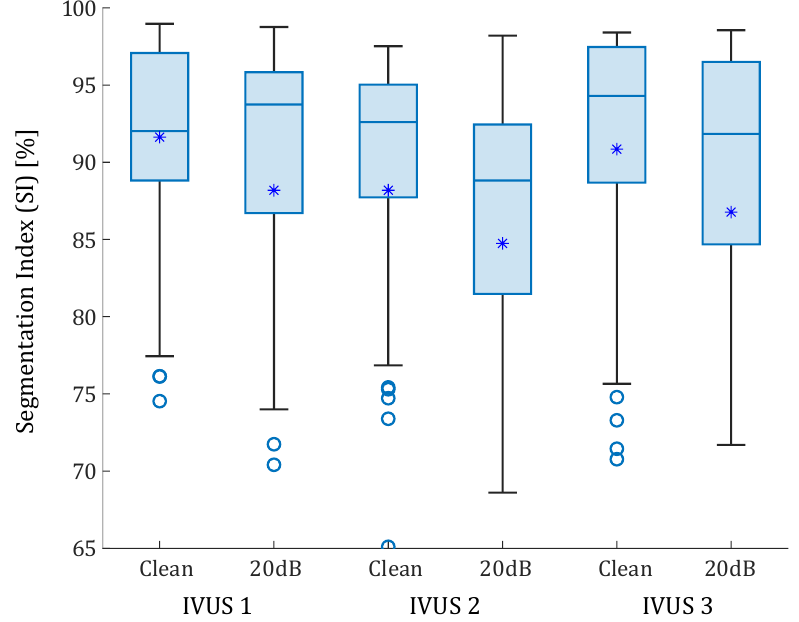
Figure 8. Box-plots of the SI values of the real IVUS geometries. The three plaques were analyzed with clean strains and with 20 dB of SNR. The median values are represented with a horizontal line. The median values were 92.02% and 93.74% for the first IVUS geometry, with and without noise; 92.60% and 88.82% for the second IVUS geometry; and 94.30% 91.84% for third IVUS geometry, respectively. Mean values are represented with asterisks. Outliers are represented with circles. Some outliers were below 65% but are not